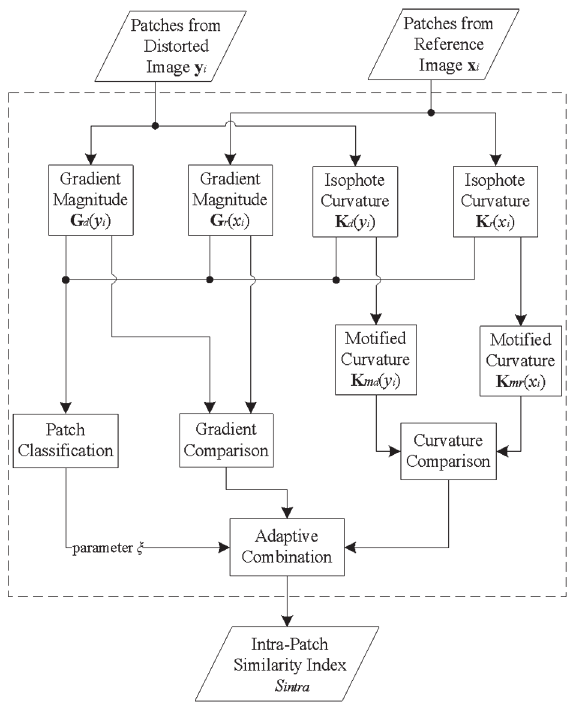
Fig 5. Flowchart of measuring the intra-patch similarity. The dashed block in Fig. 5 replaces block “ intra- patch similarity ” in Fig. 1.